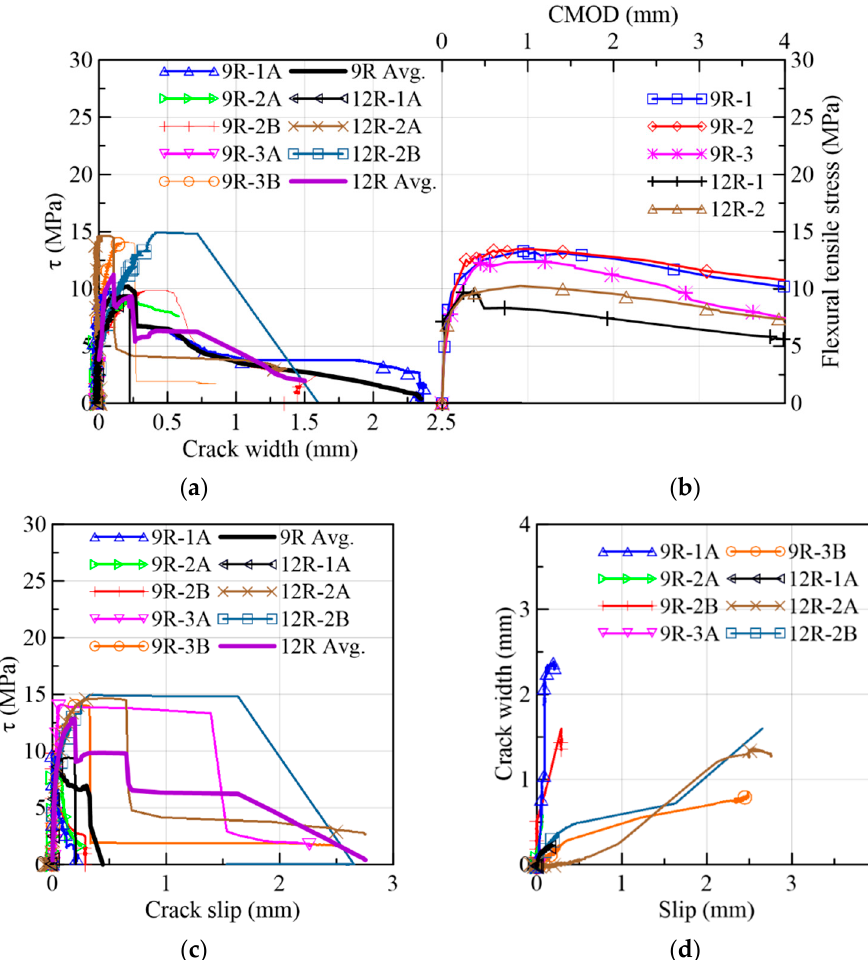
Figure 24. Mechanical results of 9R and 12R specimens: ( a ) shear stress vs. crack width; ( b ) flexural tensile stress vs. CMOD; ( c ) shear stress vs. slip; ( d ) crack width vs. slip.